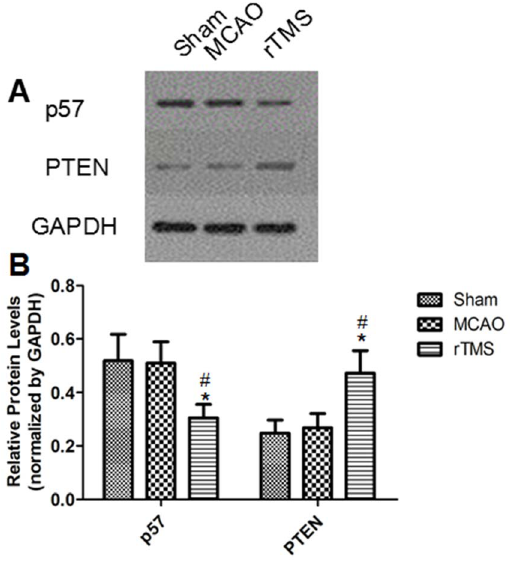
Figure 6. Expression changes of p57 and PTEN in the ipsilateral cortex 7 days after surgery. (A) Electrophoresis of p57, PTEN and GAPDH on gel. (B) The ratio of the target genes to GAPDH in different groups. # P =0.005 for p57 compared to the Sham group; # P =0.004 for PTEN compared to the Sham group; * P =0.007 for PTEN compared to MCAO